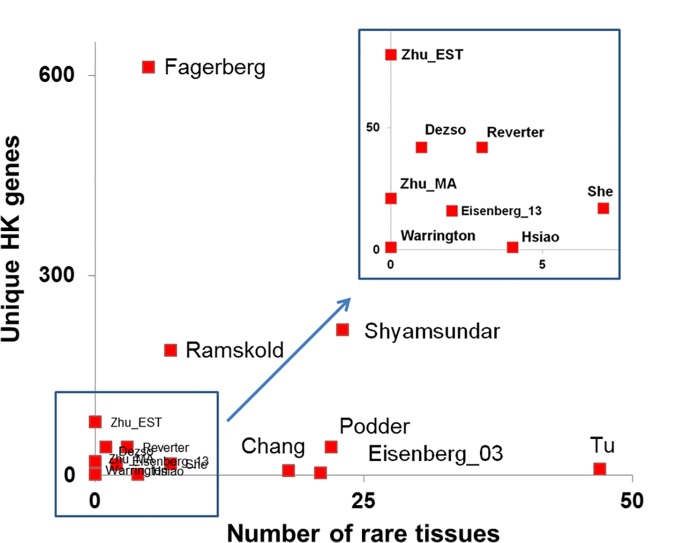
Distribution of number of unique genes (DB = 1) and the number of rare tissues, i.e. tissues used by less than 2 studies.The square region is amplified for better viewing.